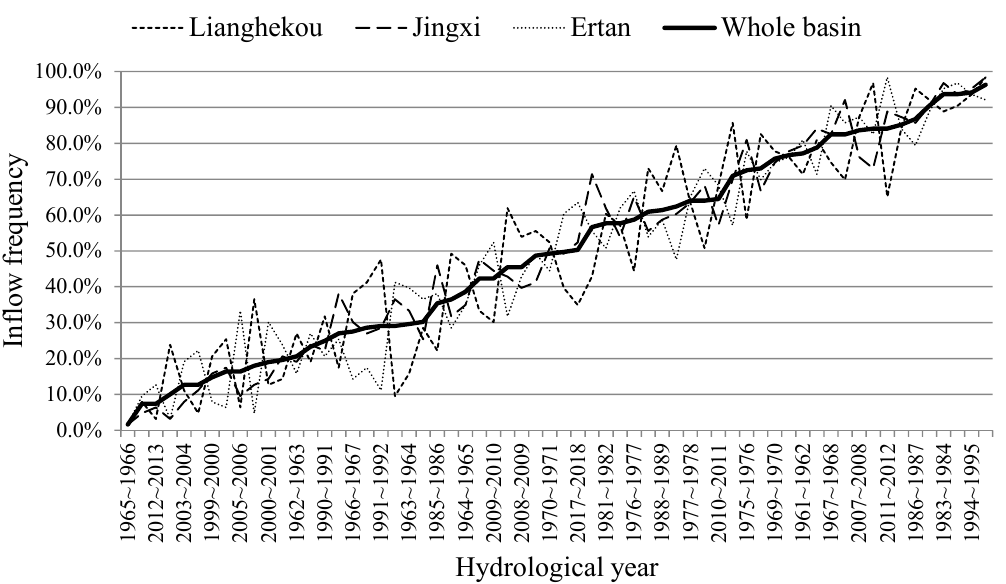
Figure 8. Inflow frequency (ascending order) of the whole basin in each hydrological year.